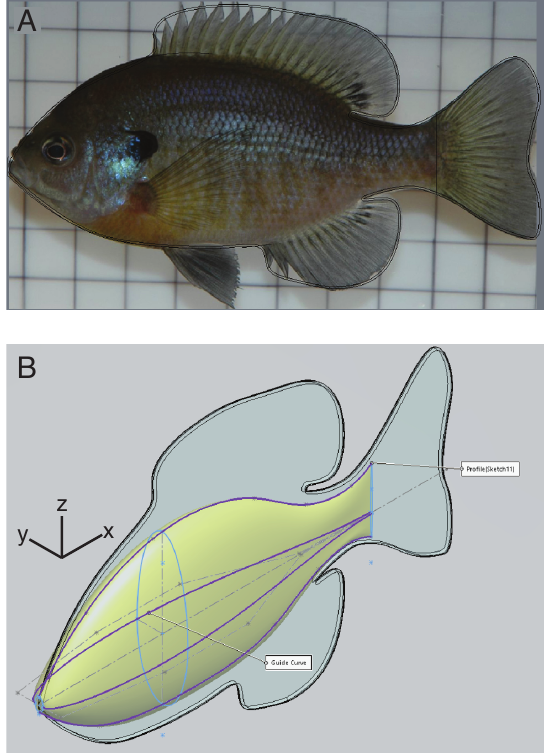
Figure 1. Body construction. ( A ) Fins were traced (black line) from a lateral image of a bluegill sunfish. ( B ) The body was constructed by smoothly changing the width and height of an ellipse (light blue), based on guide curves